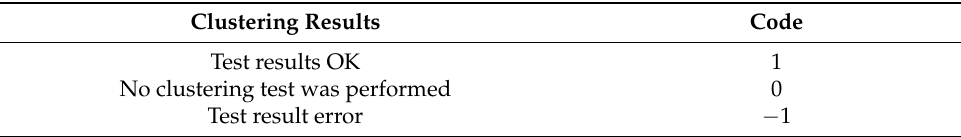
Table 4. Clustering test result